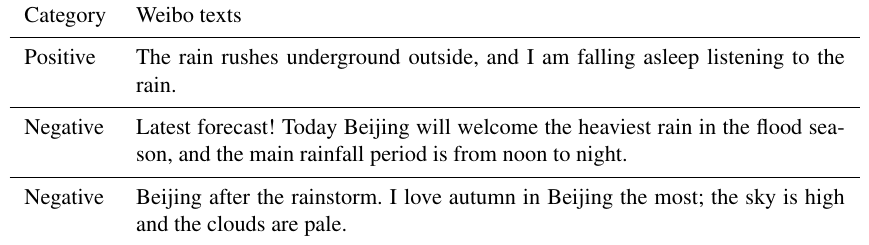
Table 1. Examples of positive (with timely disaster situation) and negative (without timely disaster situation) Weibo